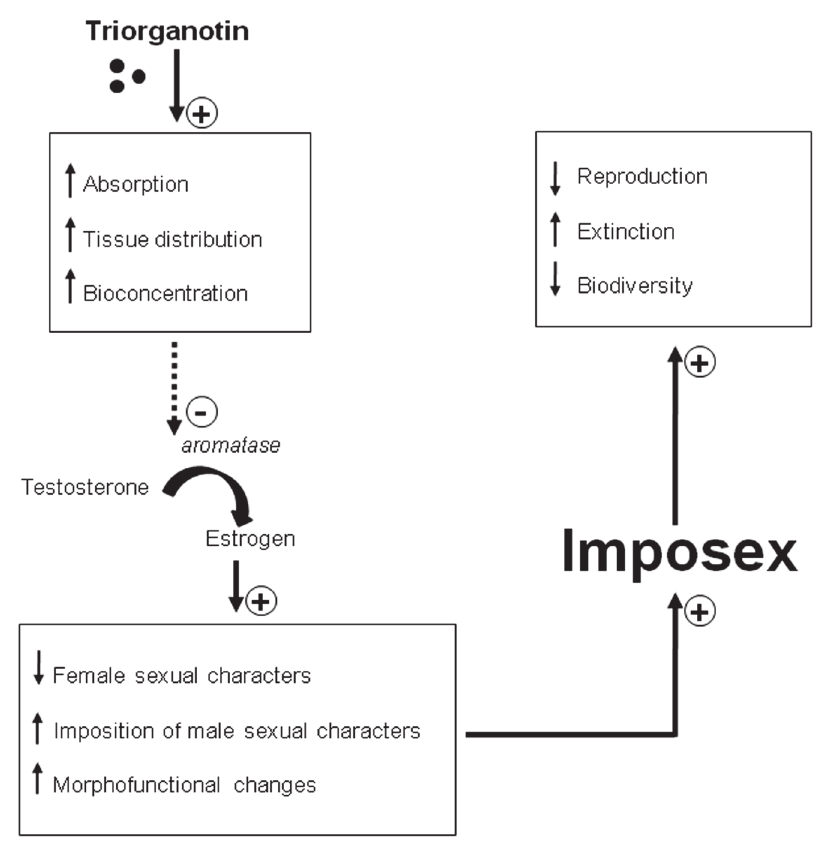
Figure 1. Diagram illustrating the down-regulation of effective aromatase activity mediated by triorganotin in mollusks, inducing imposex. The dashed arrow and the continuous arrows indi- cate an inhibitory (-) and a stimulatory (+) effect,